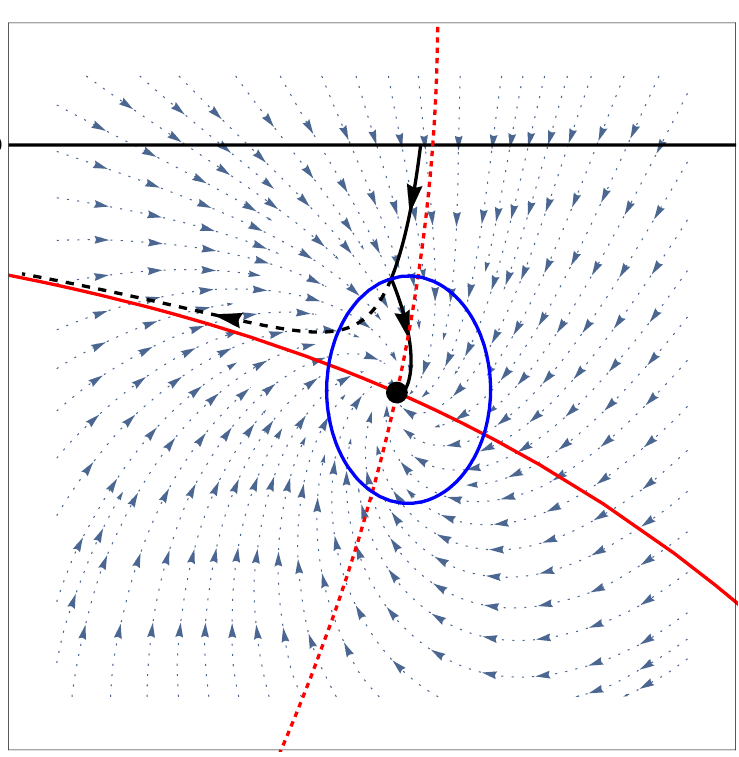
Figure 1: Visualization of the fixed point search via an axis scan. Red are the thimble (solid) and the anti-thimble (dashed). The steepest ascent equation (5) is solved using a starting point on the real axis close to the anti-thimble, once it is close to the fixed point (i.e. the derivative of the action is smaller than some value δ , visualized by the blue circle), the flow is switched according to equation (8), and will end in the fixed point (solid black arrows). The steepest ascent without switching close to the fixed point will asymptotically approach the thimble (black dashed